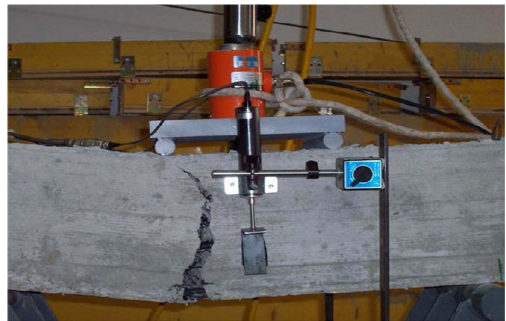
Fig. 8 Three-point loading test on concrete containing coarse rub- ber